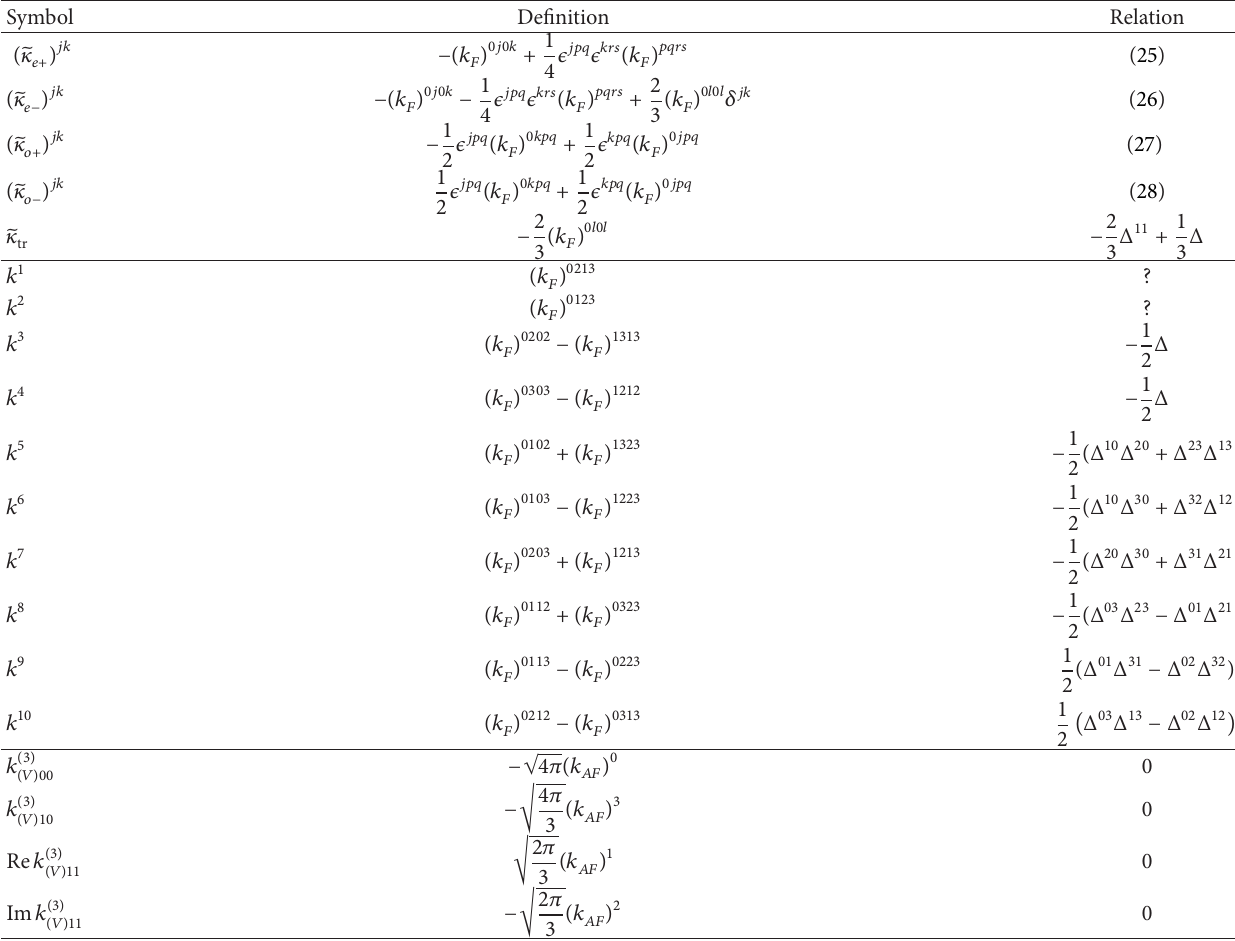
Table 3: Definitions for the photon sector in the minimal SME, together with relations with the Lorentz violation matrix of the SMS (the two left columns are from